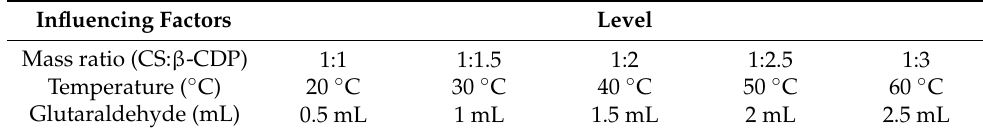
Table 9. Single-factor experimental